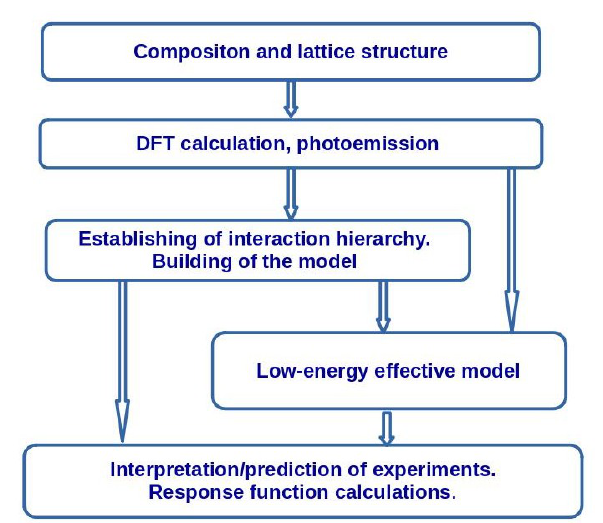
Figure 13. Scheme of the building of a microscopic model for a description of a specific